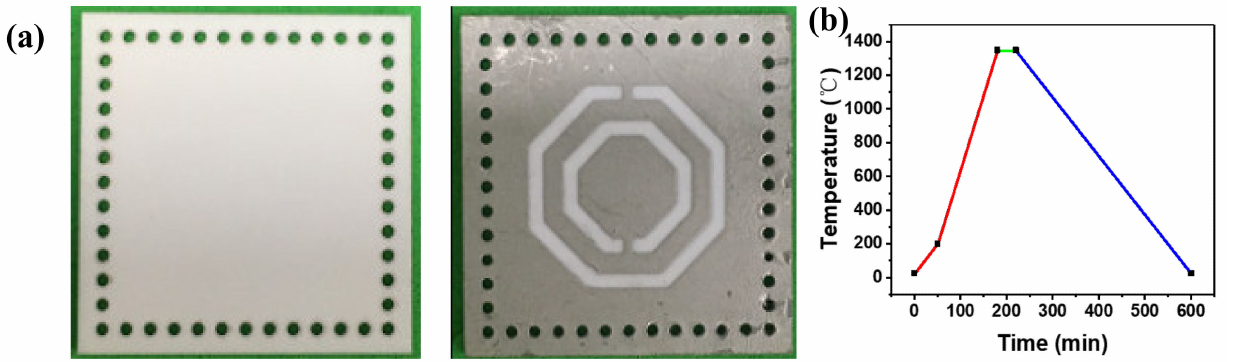
Figure 8. ( a ) Alumina ceramic substrate and fabricated sensor. ( b ) Sintering curve of platinum